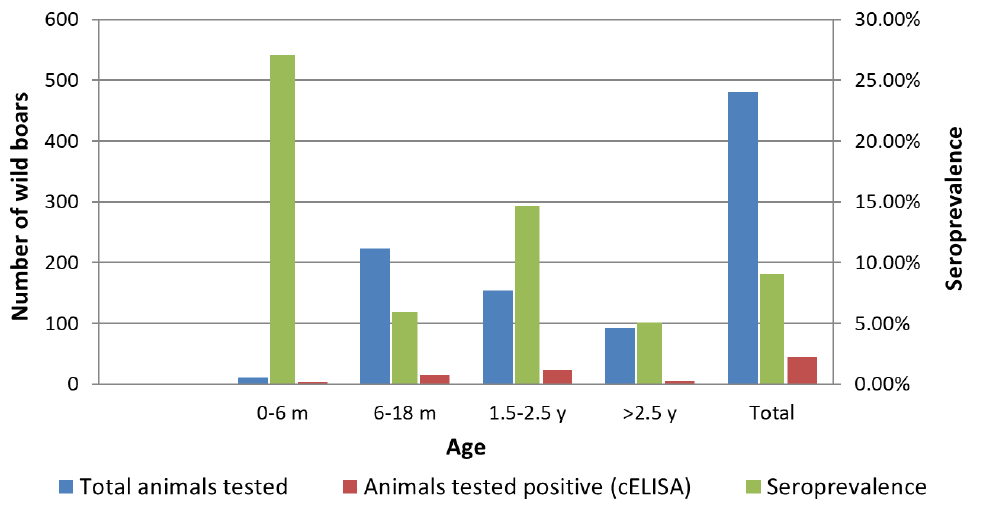
Figure 2. Distribution of the total tested wild boars, the number of Brucella seropositive individuals and the determined seroprevalence of brucellosis in different age groups of wild boars.